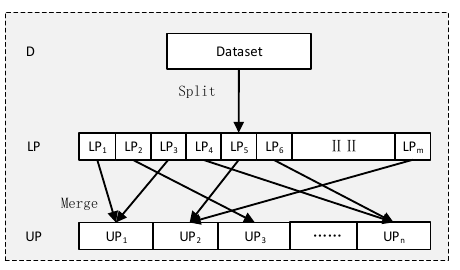
Figure 4. A brief structure of two-level partition (TLP).